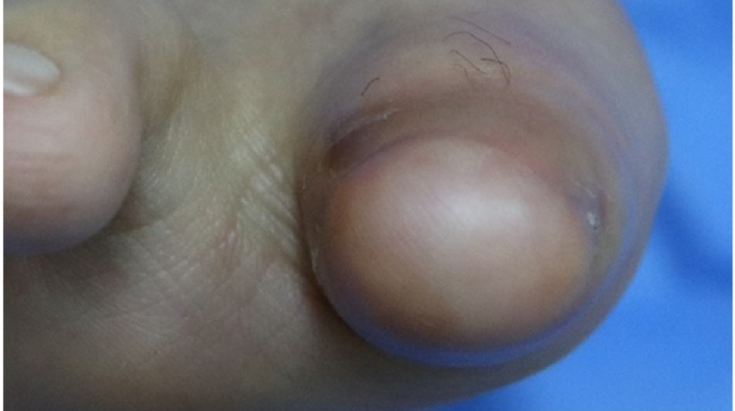
Figure 3. Four-month follow-up images showing satisfactory recovery without serious